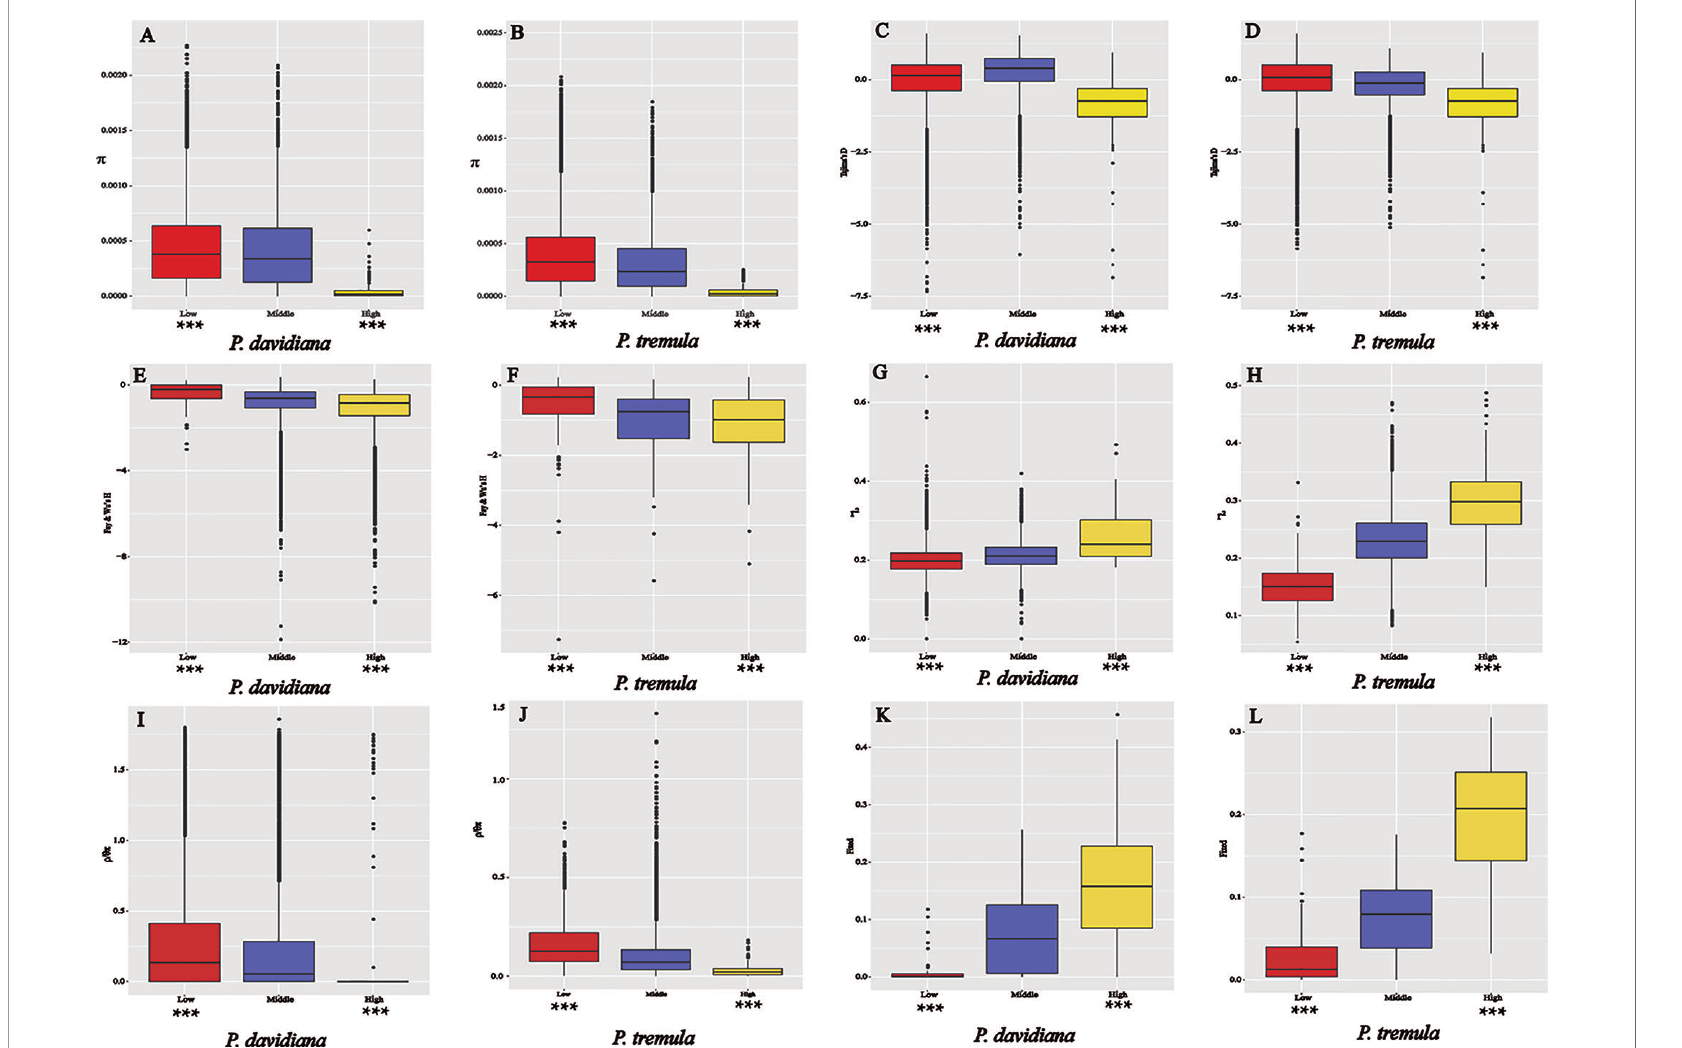
FIGURE 8 | The outlier regions that have been tested to be signi fi cantly in fl uenced by natural selection. (A, B) Comparisons of nucleotide diversity p among regions displaying signi fi cantly high (yellow boxes) and low (red boxes) differentiation versus the genomic background (blue boxes) between P. davidiana and P. tremula .; (C, D) Comparisons of Tajima ’ s D in P. davidiana and P. tremula ; (E, F) Comparisons of Fay & Wu ’ s H in P. davidiana and P. tremula ; (G, H) Comparisons of r 2 in P. davidiana and P. tremula ; (I, J) Comparisons of recombination rate ( r / q p ) in P. davidiana and P. tremula ; (K, L) Comparisons of the proportion of fi xed differences caused by derived alleles fi xed in P. davidiana and P. tremula . Asterisks designate signi fi cant differences between outlier windows and the rest of genomic regions by Mann – Whitney U test (*P- value <0.05; **P-value <1e − 4; ***P-value <2.2e −